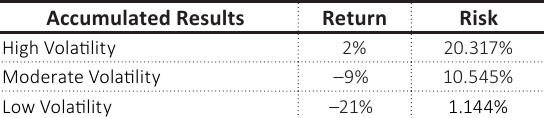
Table 2. Portfolio accumulation results